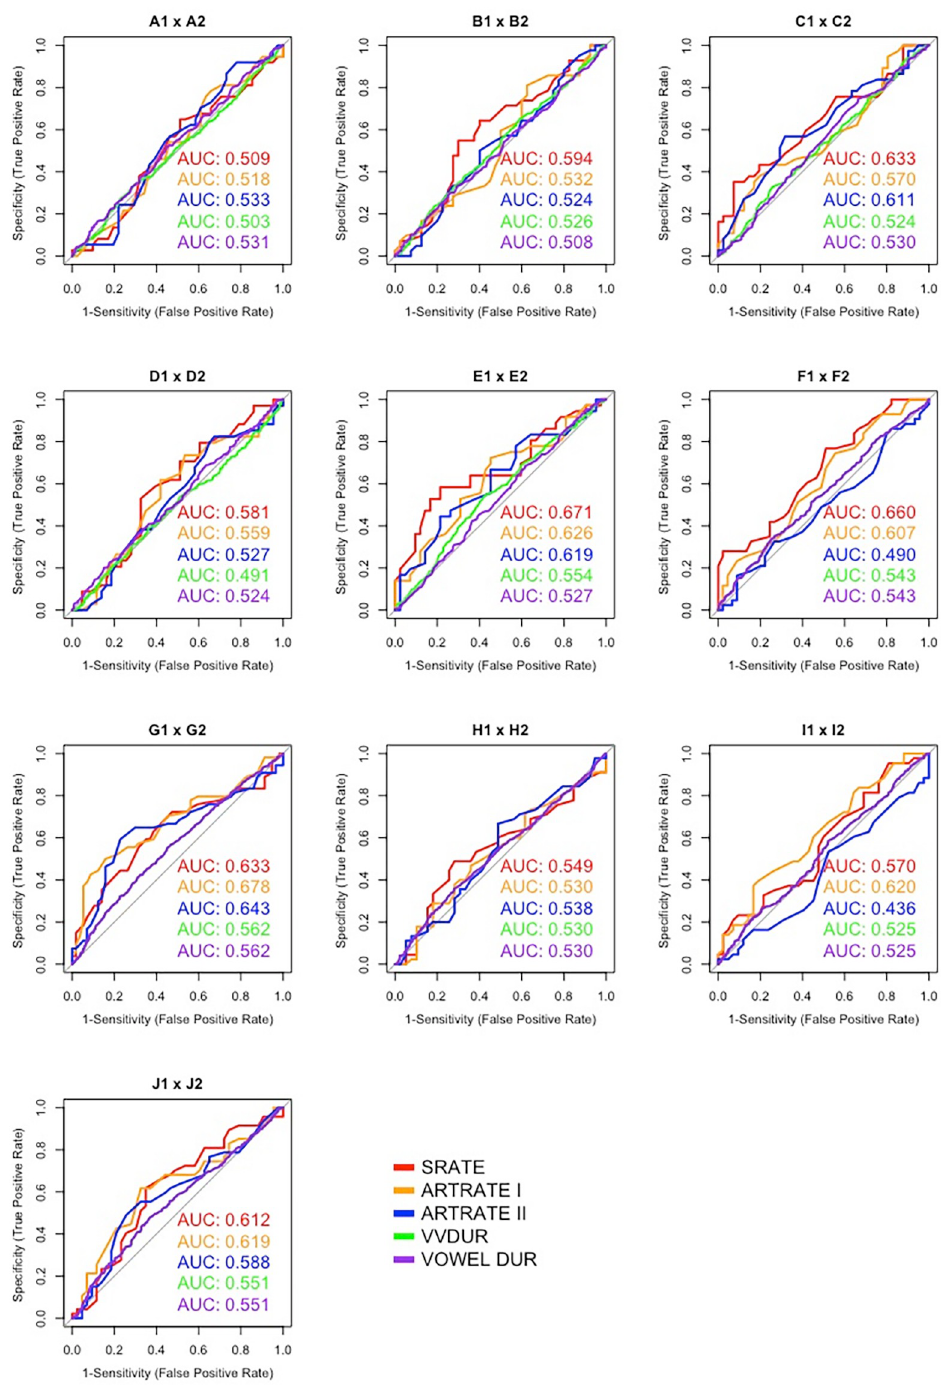
Fig 3. ROC curves and AUC values for intra-twin pair comparisons.